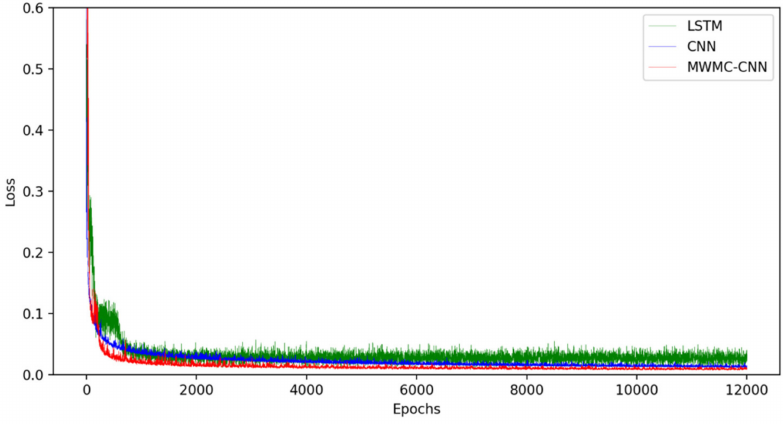
Figure 8. The loss curves of LSTM, CNN and